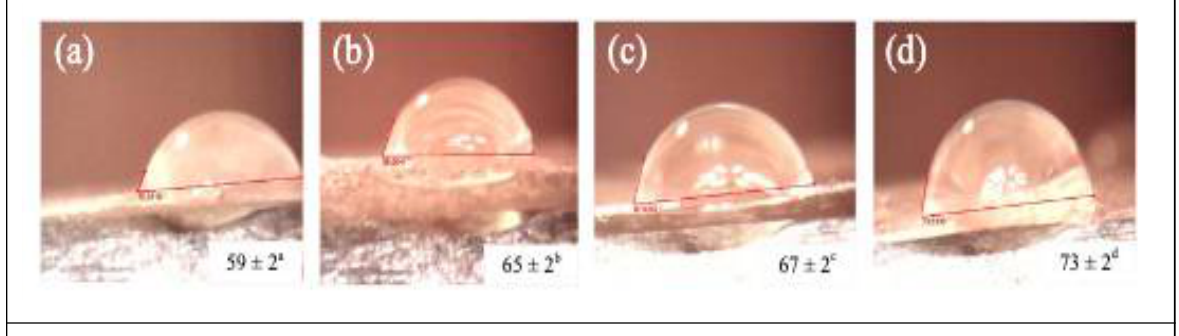
Figure 12: Water Contact Angle measurements of plantain flour film with aloe vera gel at (a) 0%, (b) 2%, (c) 4% and (d) 6% (Gutiérrez and González,